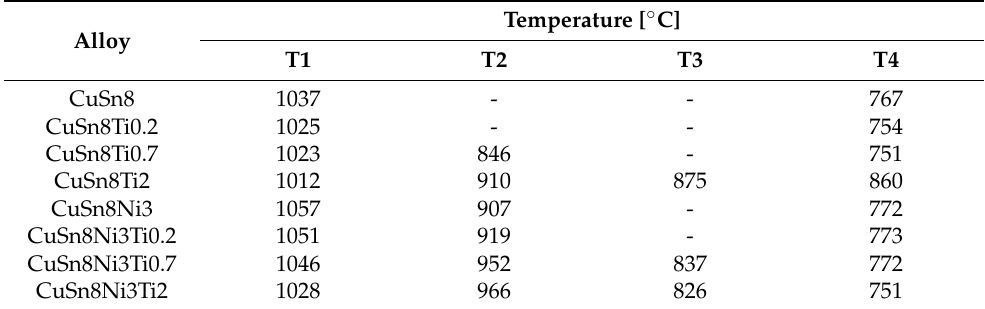
Table 2. The results of the characteristic temperatures determined on the basis of the TDA analysis. Alloy